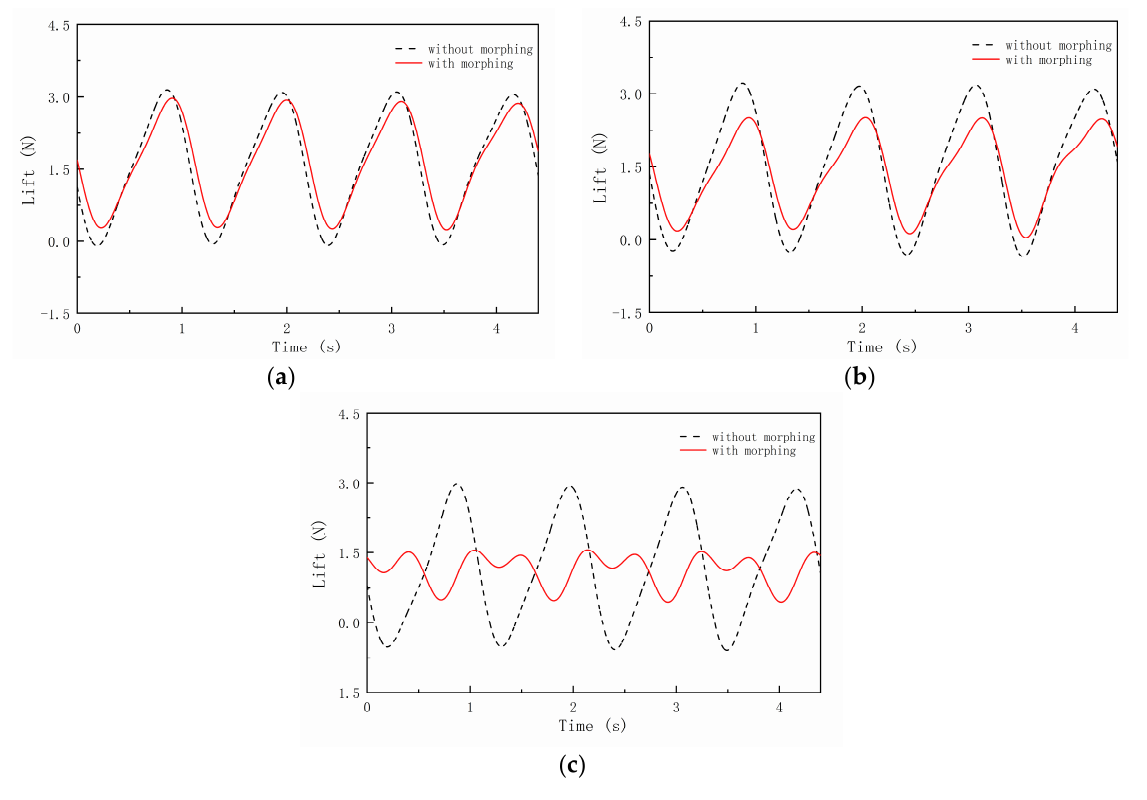
Figure 18. Lift force variation of different morphing part lengths at 4° AOA. ( a ) b/4 morphing part length, ( b ) b/3 morphing part length and ( c ) b/2 morphing part length.